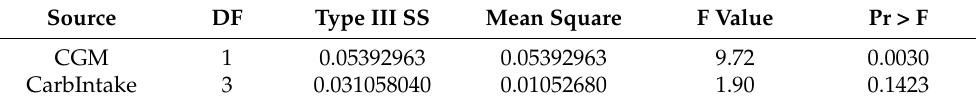
Table A12. Log A1C ≥ 1.95% with CGM and CarbIntake as independent